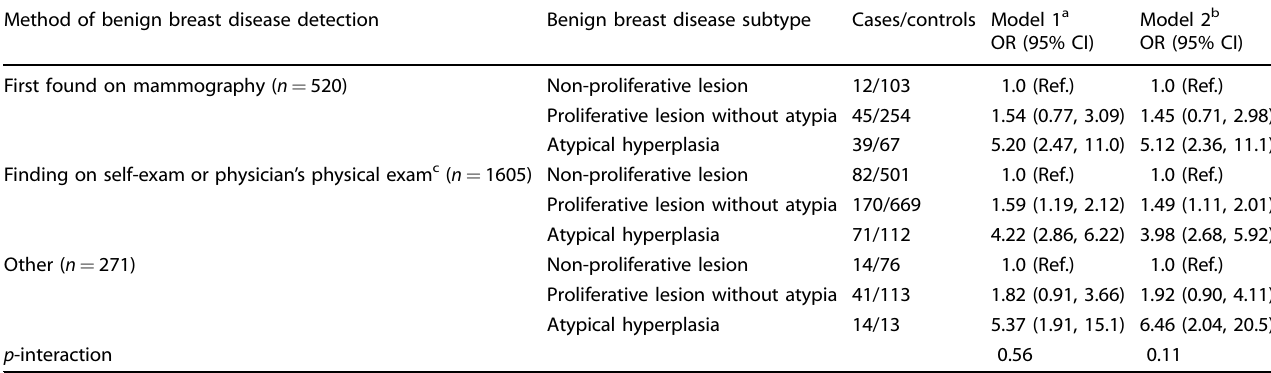
Table 3. ORs and 95% CIs for the associations between benign breast disease subtypes and breast cancer risk, strati fi ed by the method of BBD